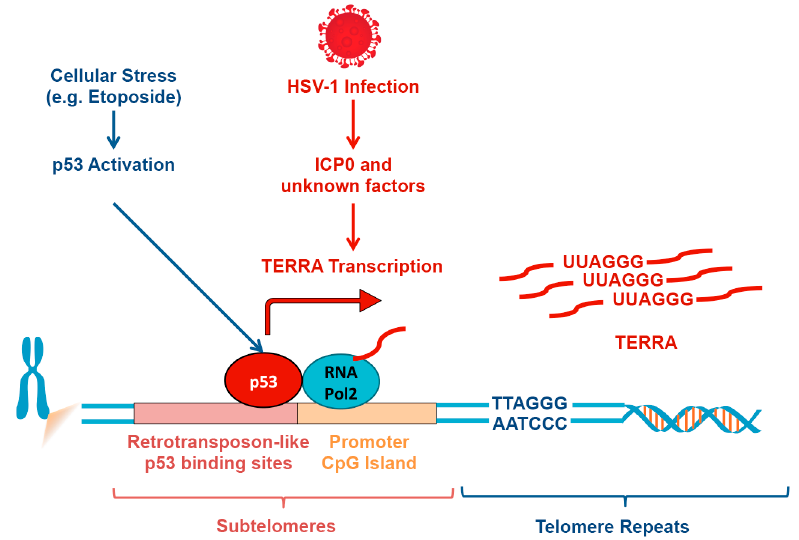
Figure 3. Induction of TERRA through subtelomeric retrotransposon-like p53 binding sites. Virus infection (e.g., HSV-1), as well as other cell stress pathways (e.g., DNA-damage, oxidative stress), can induce TERRA expression. Stress-associated p53 can bind subtelomeres to activate TERRA transcription. Subtelomeric p53 binding sites are evolutionarily derived from retrotransposon-like elements.